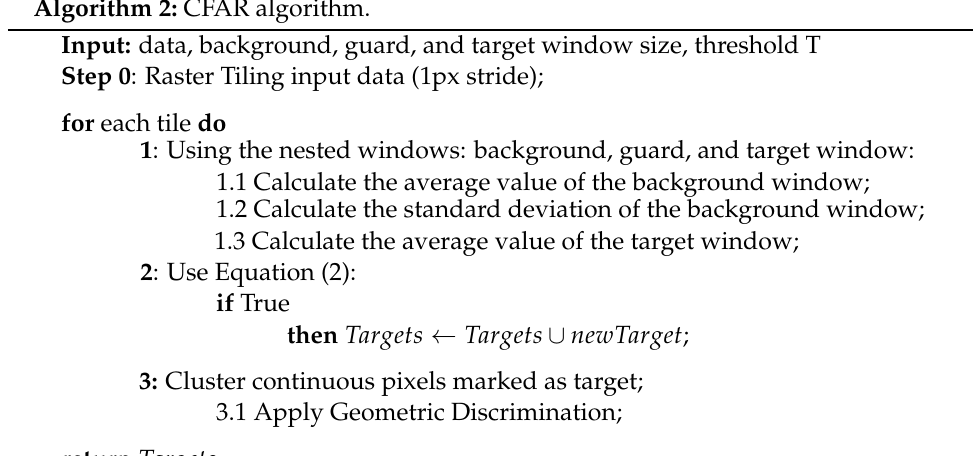
Algorithm 2: CFAR algorithm.